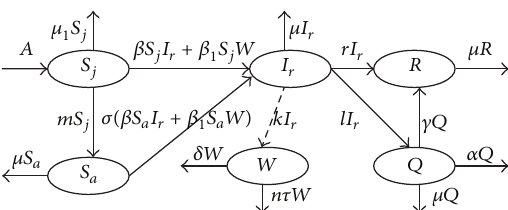
Figure 1: Transmission diagram on the dynamical transmission of S. suis